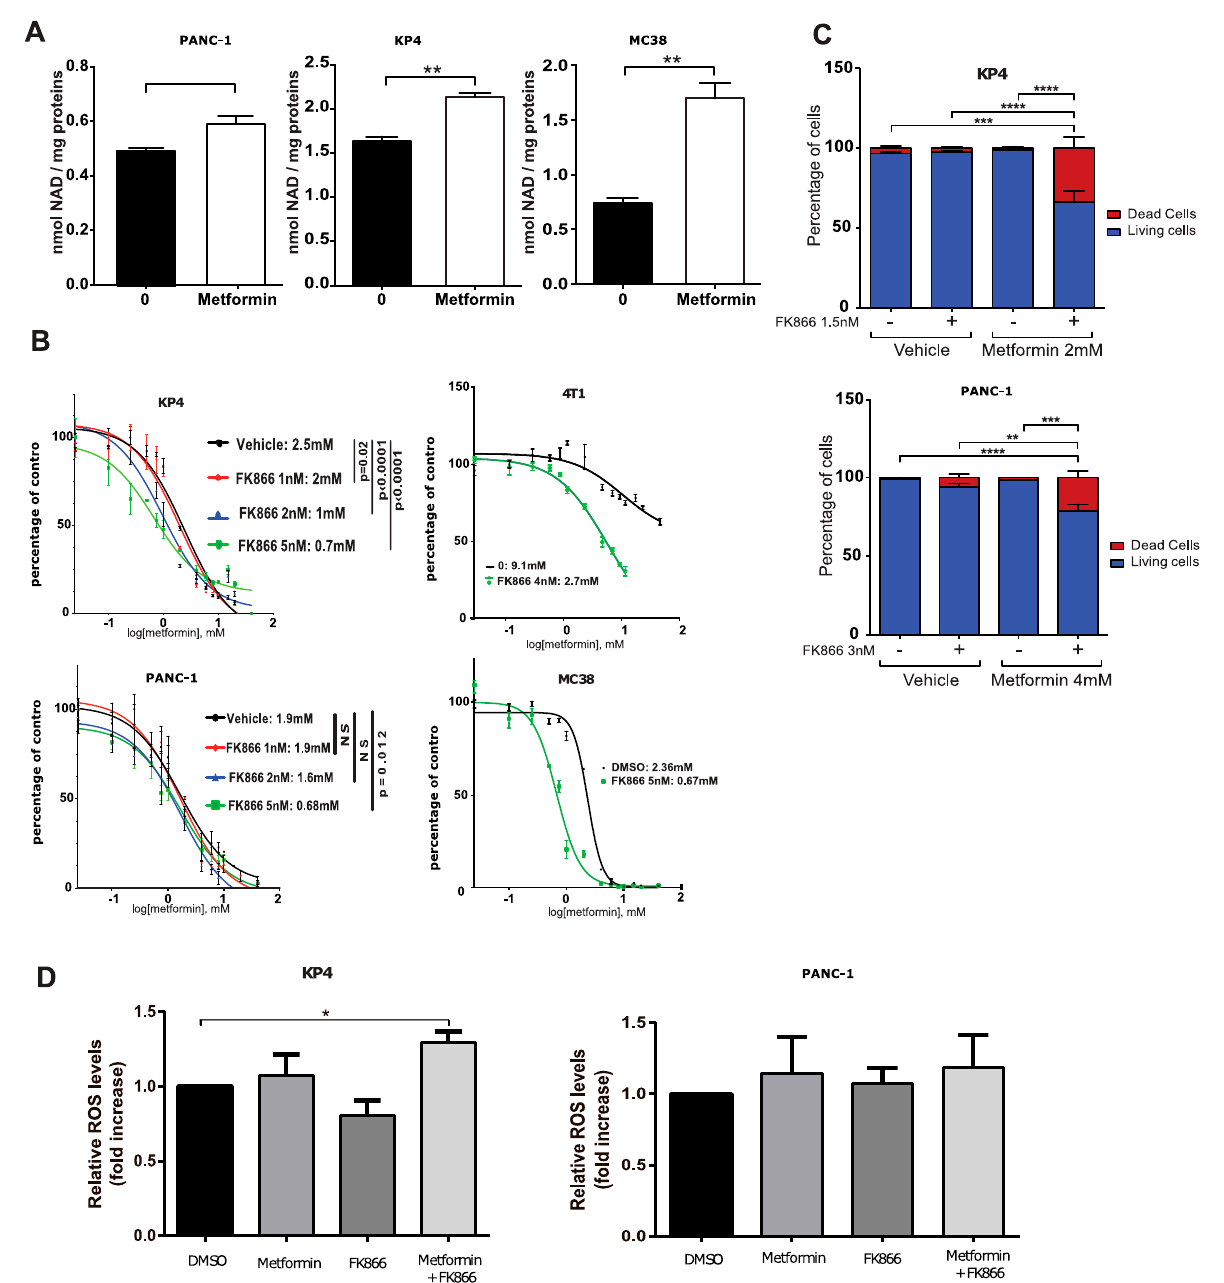
Figure 2. The NAMPT inhibitor FK866 and metformin cooperate to inhibit PDAC cells growth by strongly perturbing NAD metabolism. ( A ) Total NAD level in PDAC cells grown for 24 h in the presence or absence of 10 mM metformin. * p -value ≤ 0.05, ** p -value ≤ 0.01 (student t -test). ( B ) Dose- response curves and IC50s of metformin on growth of PDAC cell KP4 and PANC-1, breast cancer cells 4T1, and colon cancer cells MC38 treated with FK866 or vehicle for 3 days. ( C ) Viability (cell counts with trypan blue staining) of KP4 and PANC-1 cells treated with metformin or vehicle and FK866 or vehicle for 6 days. ** p -value ≤ 0.01, **** p -value ≤ 0.0001 (Student’s t -test). ( D ) Fluorescence intensity of KP4 and PANC-1 cells stained with DCFDA and measured by flow cytometry. Data show a relative change in median fluorescence intensity over control cells. Treatment for 24 h in the presence or absence of 10 mM metformin, 5 nM of FK866, a combination of metformin and FK866, or with vehicle. ( A – C ) Values are means of triplicates ± SEM, n = 3; for ( D ), values are means of duplicates ± SEM. ** p -value ≤ 0.01, *** p -value ≤ 0.001, **** p -value ≤ 0.0001 (ANOVA).